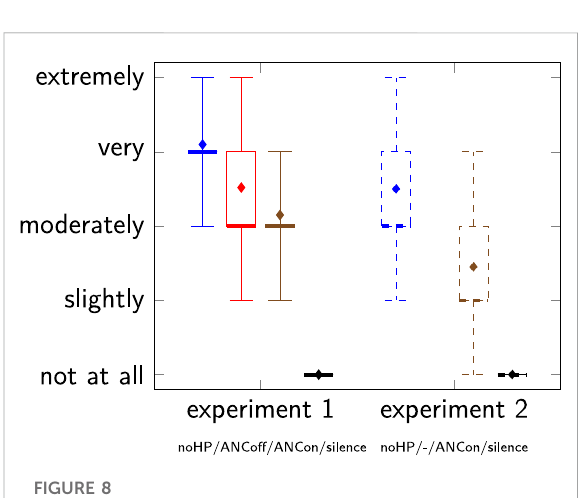
FIGURE 8 Boxplots, showing the perceived speaker loudness.